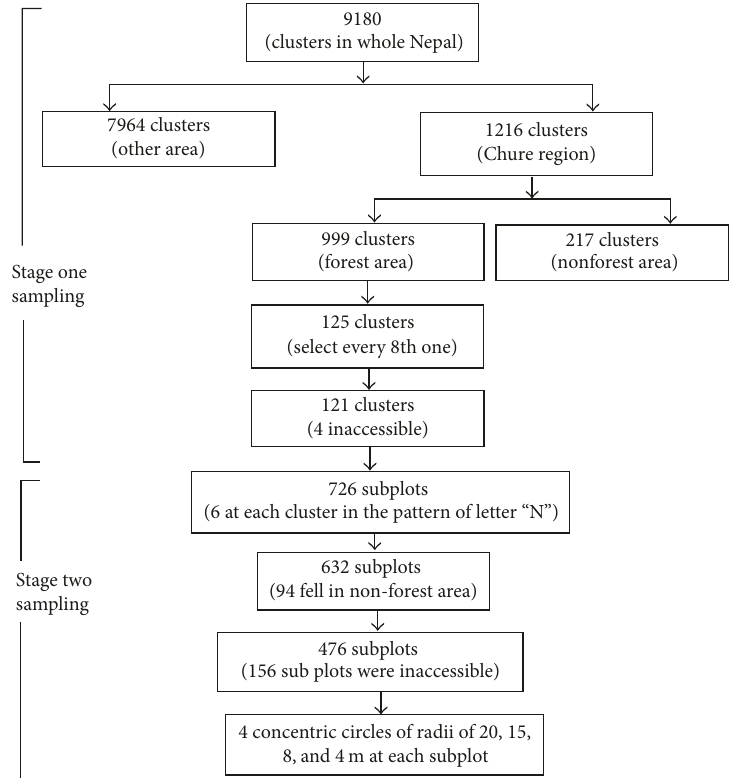
Figure 2: Methodological flow of two-stage sampling.